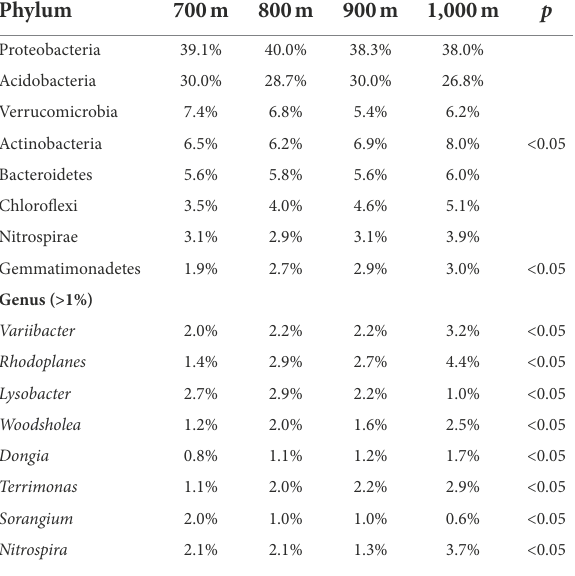
TABLE 3 Relative abundance of the dominant bacterial phyla (top) and genera (bottom) in the soil along an altitudinal gradient in the Changbai Mountains, northeastern